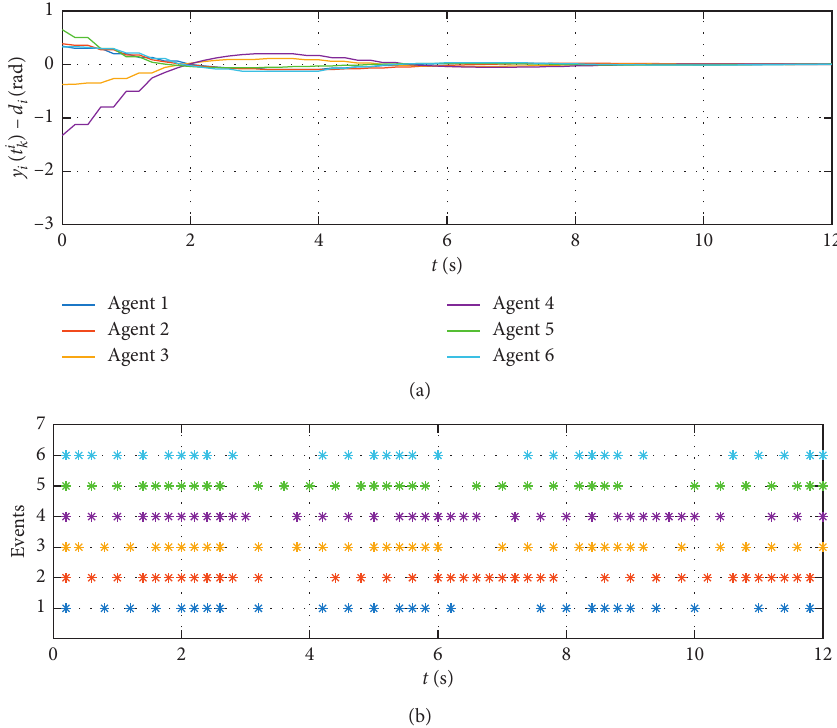
( t i ) − d i � 1 , 2 , ... , N when h � 0 . 2s. i i for k